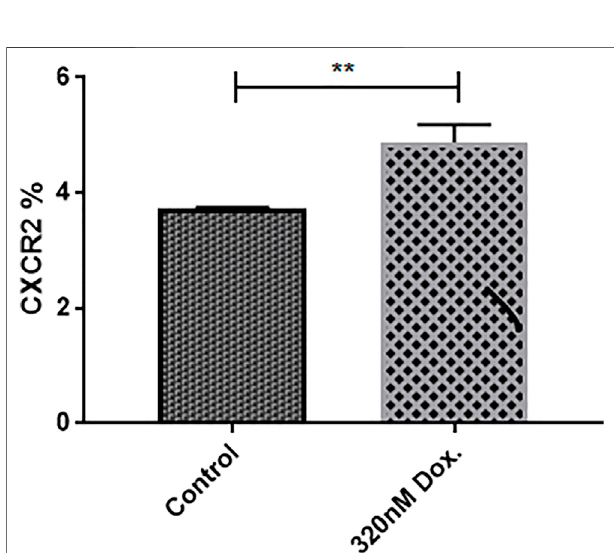
FIGURE 3 | Doxorubicin induces higher CXCR2 expression level in MDA-MB-231 mammospheres. The c yto fl uorimetric analysis for CXCR2 expression in mammospheres in control and treated conditions; data are expressed as CXCR2 percentage; Dox: doxorubicin. p values, unpaired Student ’ s t-test.